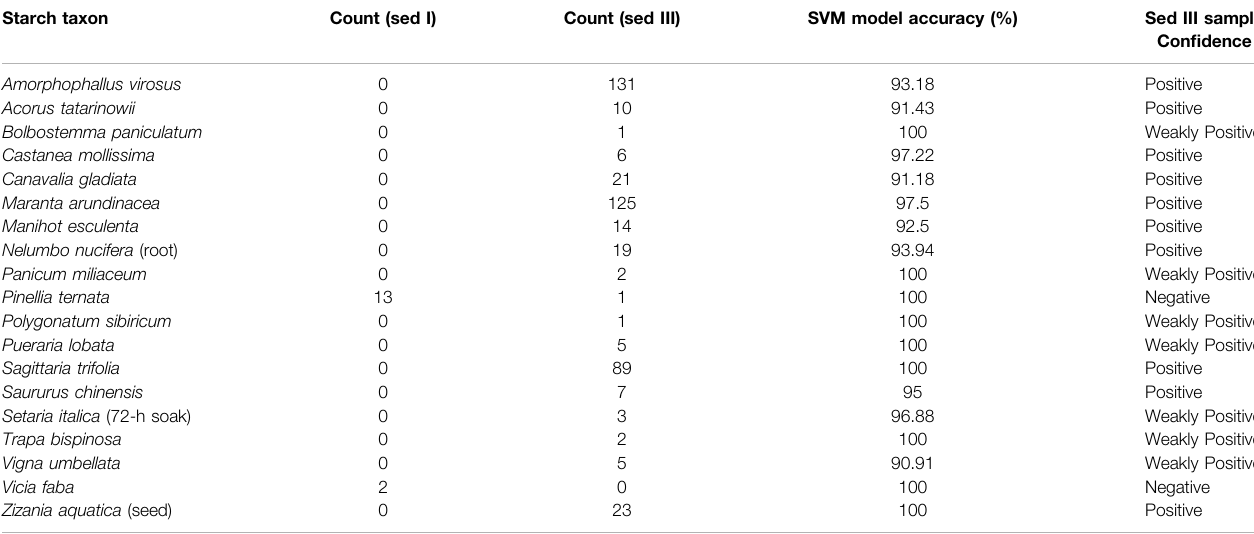
TABLE 2 | Extrapolated identi fi cation of archaeologically-derived starch granules from the Dingsishan Neolithic site. Starch